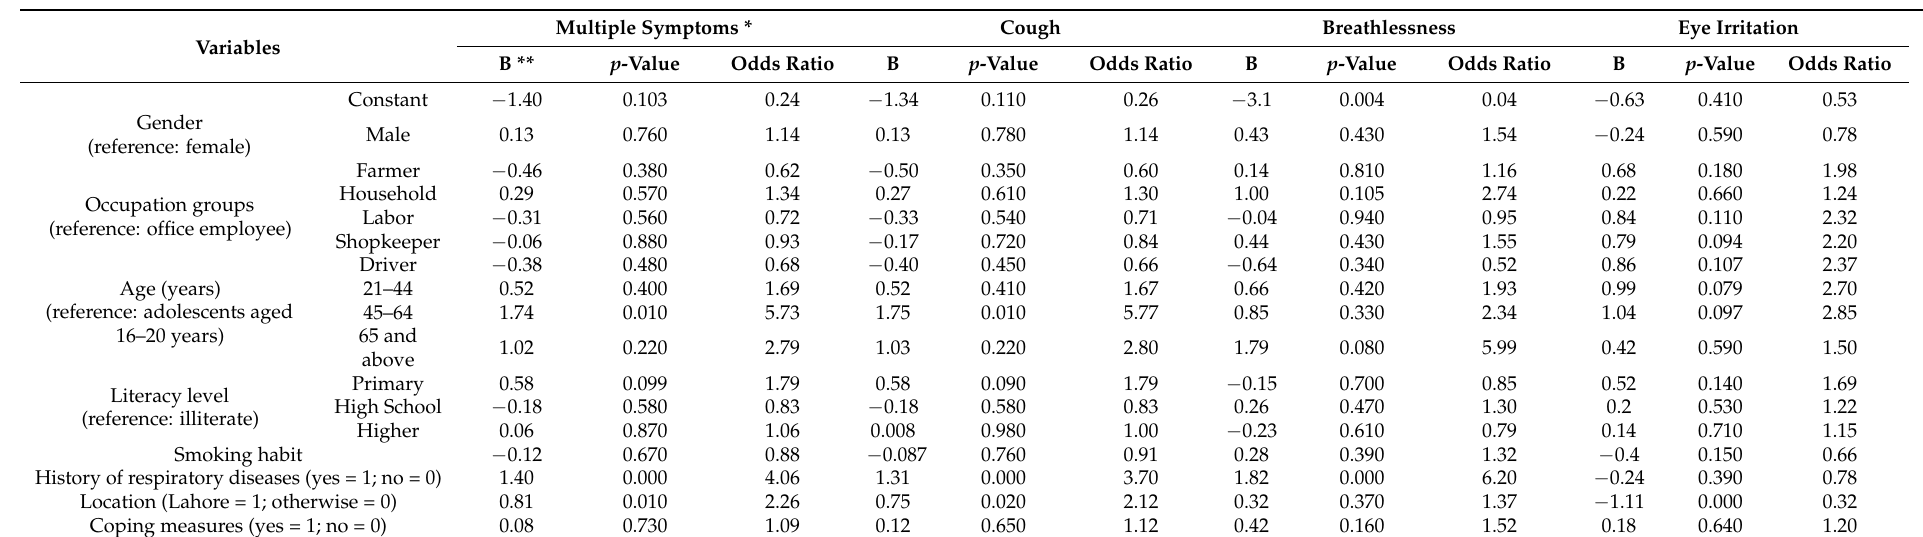
Table 4. Predictors of health symptoms among exposed